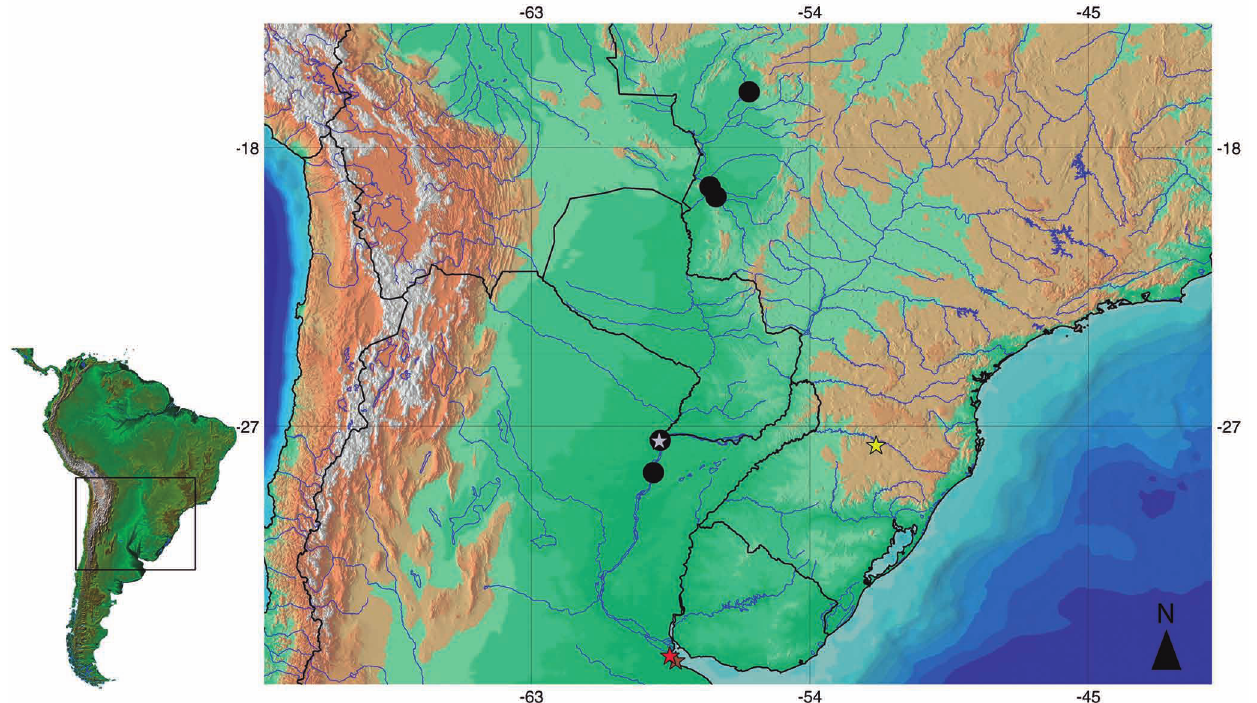
Fig. 7. Partial map of South America with the geographic distribution of Pimelodus argenteus (black dots) and the type localities of P. albicans (brown star); P. atrobrunneus (yellow star); P. argenteus (gray star), and P. brevis